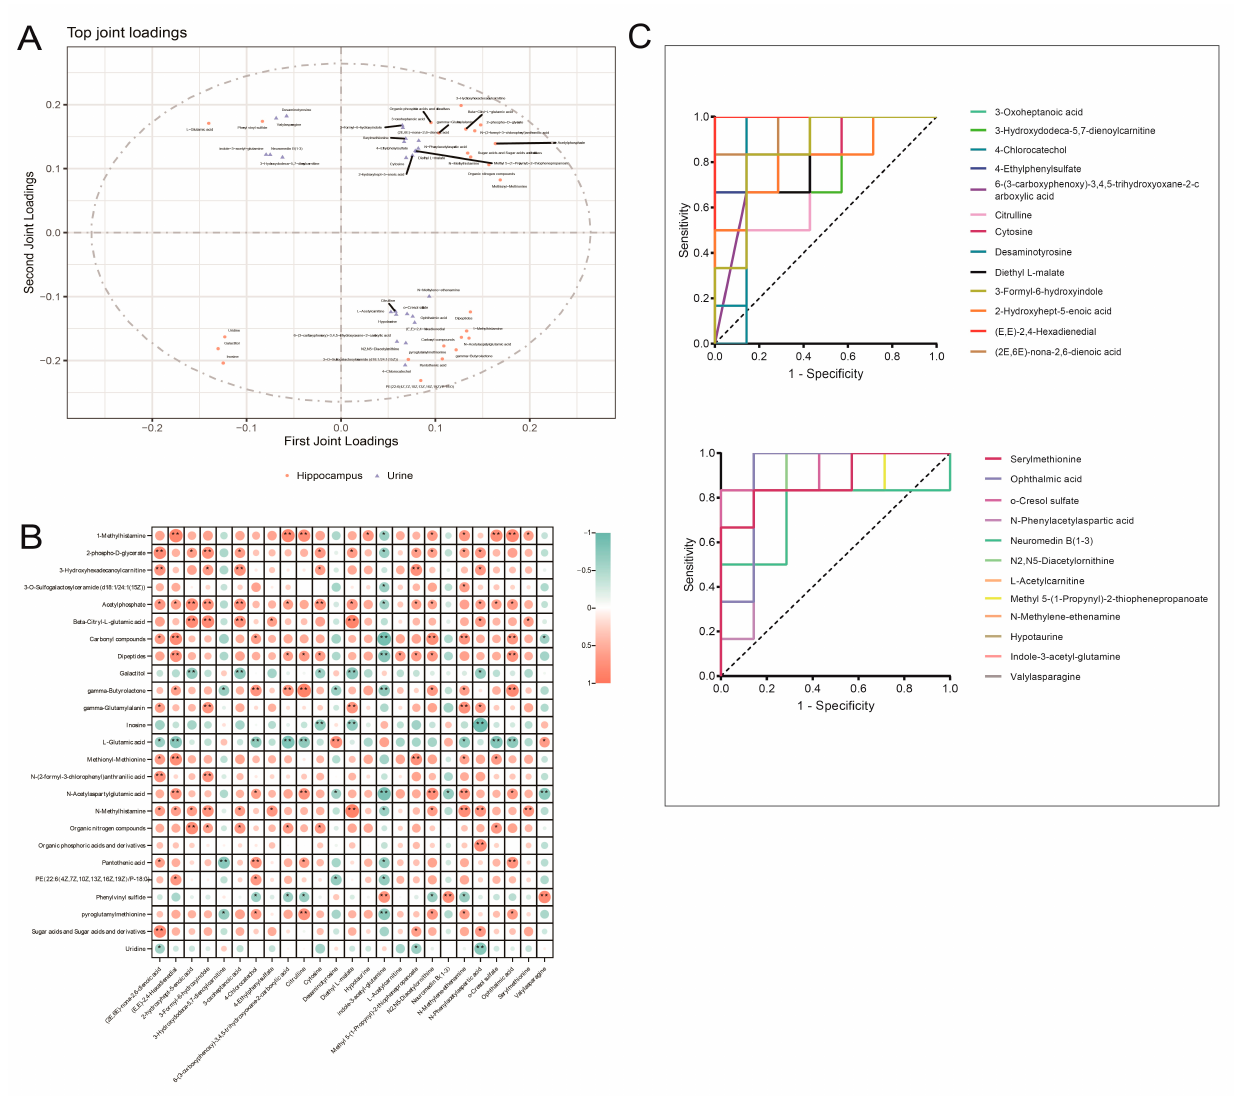
Figure 6. ( A ) Loading plot of the O2PLS model showing differential metabolites in hippocampal tissue and urine; ( B ) correlation plot illustrating the top 25 loading metabolites in hippocampal tissue and urine based on Spearman analysis, (the metabolites in urine are shown on the abscissa, and metabolites in the hippocampus on the ordinate, positive correlation is shown in orange, negative correlation in green, ** indicates p -value < 0.01 with |r| ≥ 0.6, * indicates p -value < 0.05 with |r| ≥ 0.6, and the size and depth of the circles indicate the magnitude of the correlation); ( C ) ROC analysis of the top 25 loading urine metabolites.